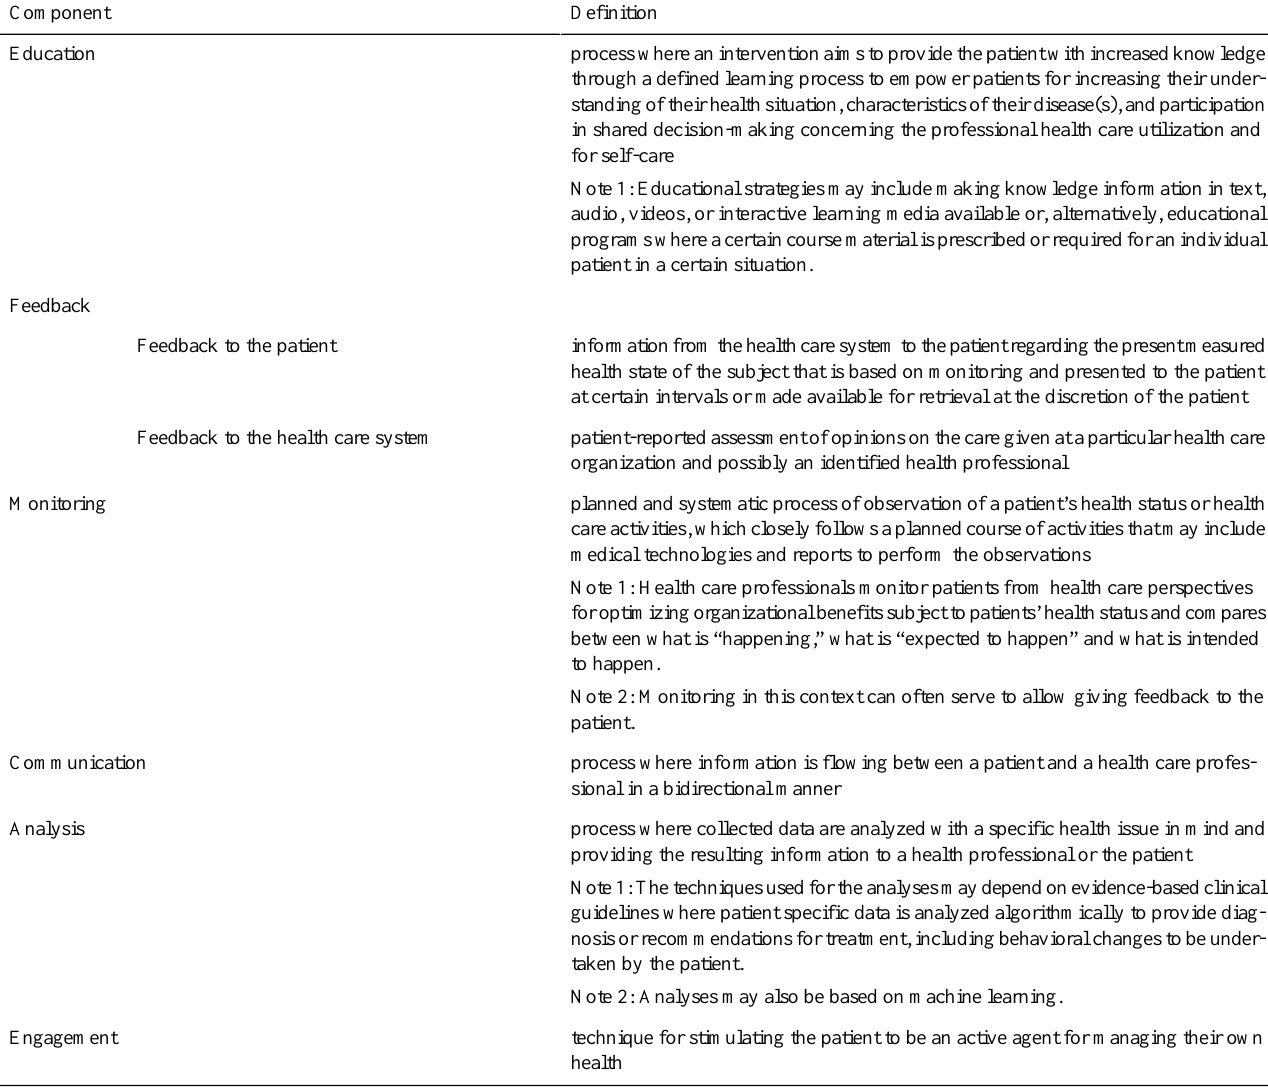
Table 3. Definitions of the information and communications technology (ICT) intervention